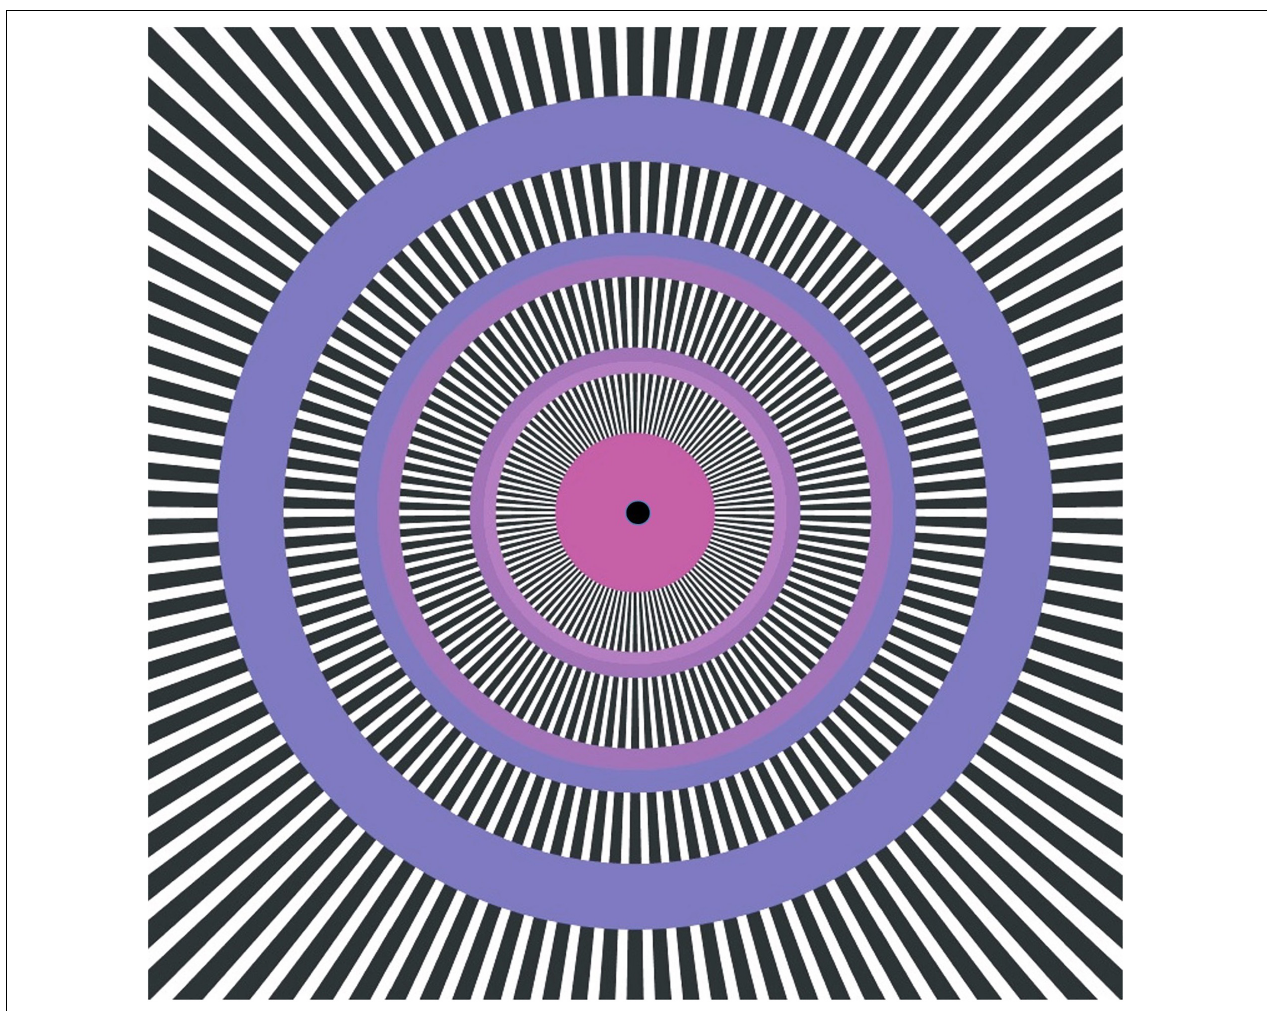
FIGURE 11 | The Leviant “Enigma” figure, illustrating the “traffic illusion” and “perceptual tachyons” (see text); an illusion of fiction and ambiguity of the visual